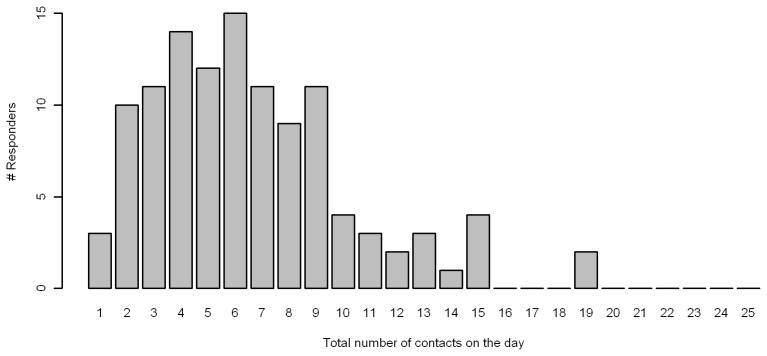
Histogram of the total number of contacts per day/per respondent.